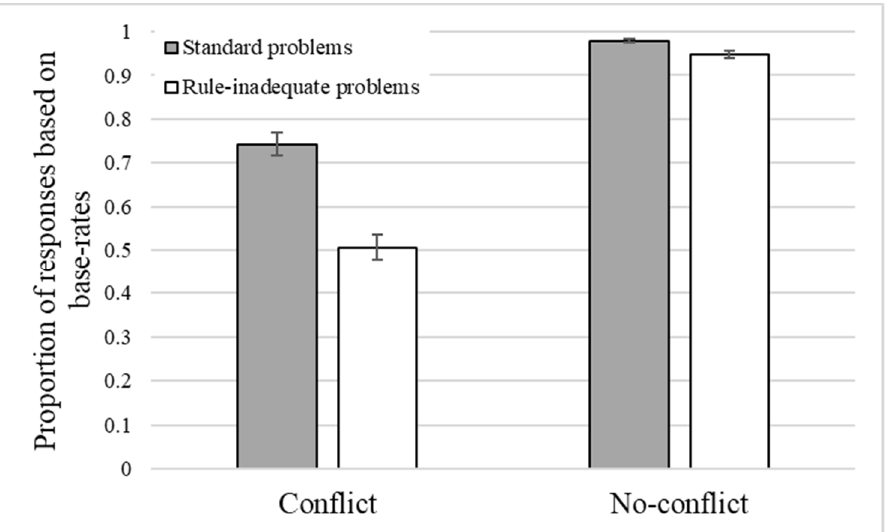
Figure 3. Proportion of correct responses to no-conflict problems and base-rate responses to the